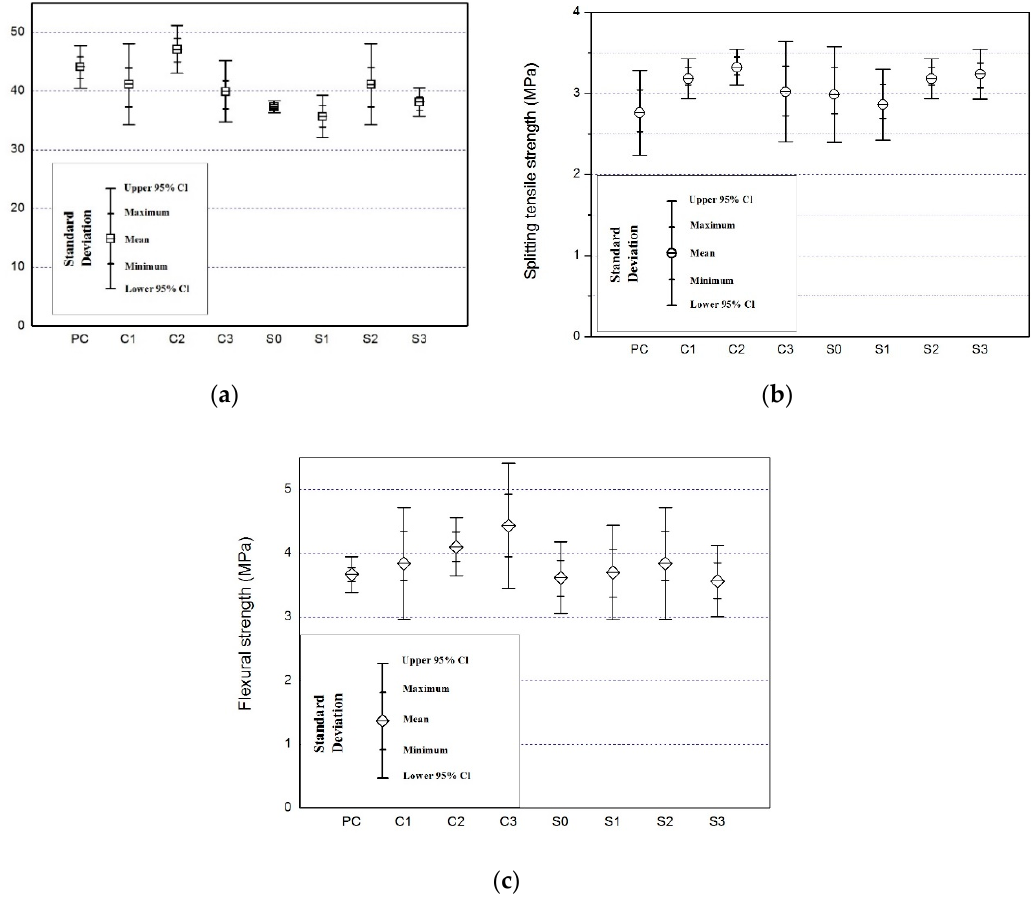
Figure 1. (a) The compressive strength of NSCFRC; ( b ) tensile splitting strength of NSCFRC; ( c ) The flexural strength of NSCFRC. Table 3. Compressive strength, Splitting tensile strength and flexural strength of different